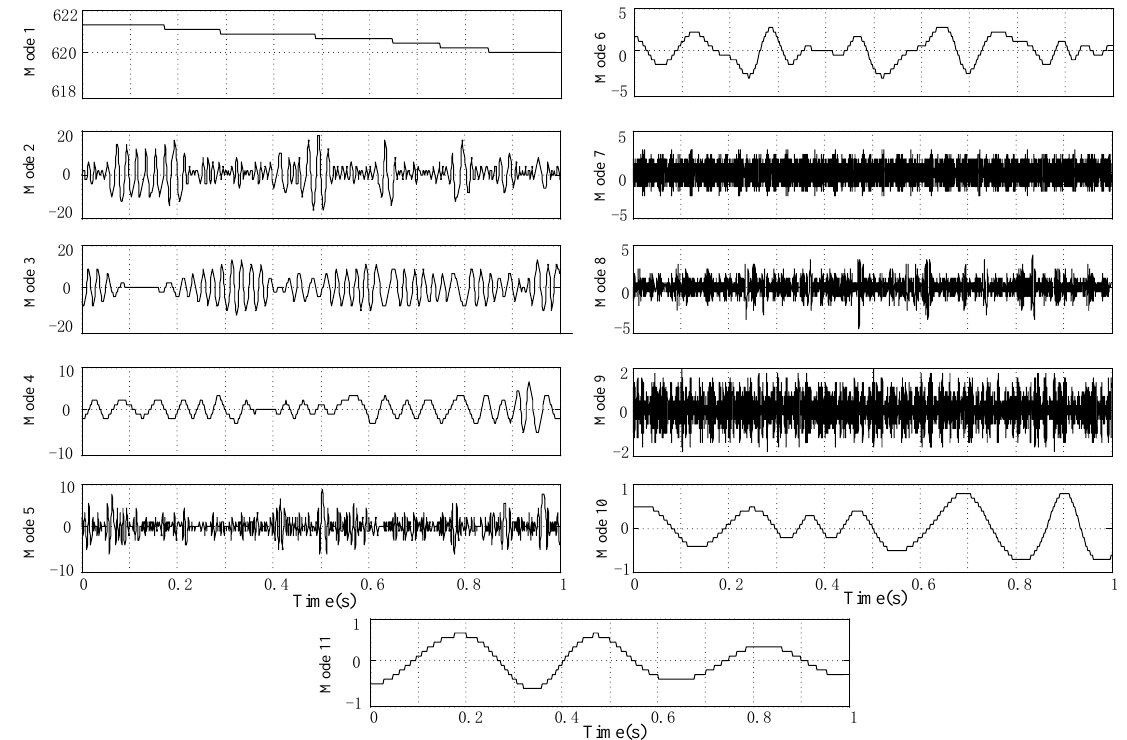
Figure 27. The decomposed modes of EMD algorithm. Table 8. Measured ripple components based on window interpolation FFT (WIFFT) algorithm.